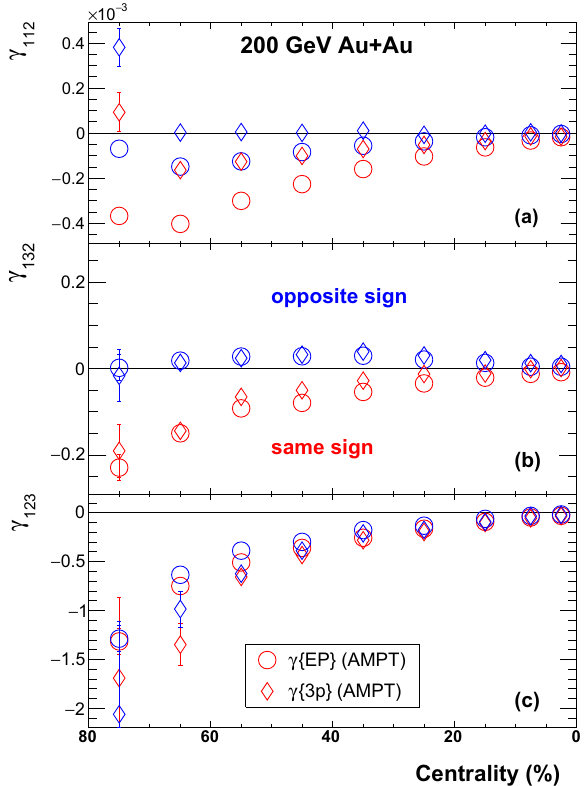
Fig. 3 Centrality dependence of γ 112 (upper), γ 132 (middle) and γ 123 (lower) for same-sign and opposite-sign particle pairs, from AMPT in √ s NN = 200 GeV. Both event plane and 3-particle Au+Au collisions at approaches are